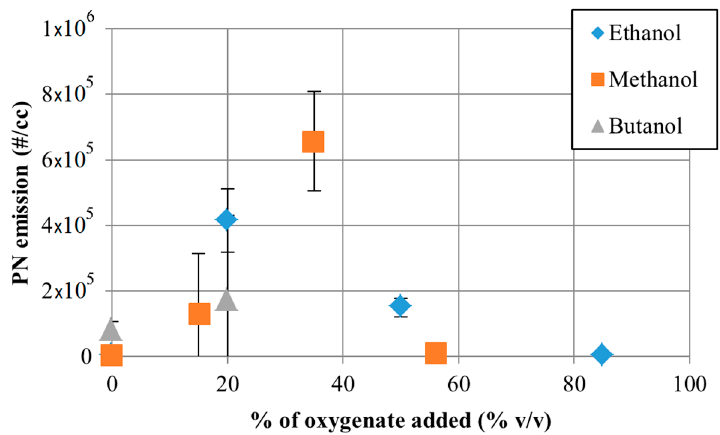
Figure 8. PN emissions a single cylinder optical engine for fuels with varying levels of oxygenates, the error bars correspond to ± σ [142].